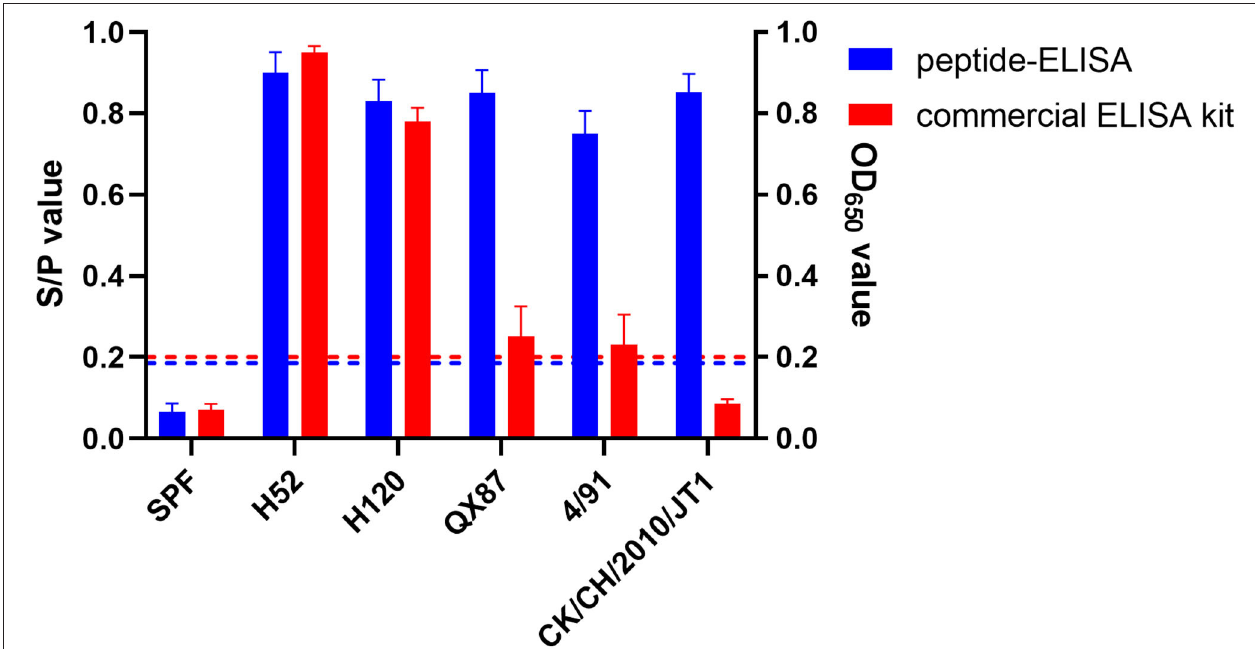
FIGURE 3 | Reactivity of pELISA and positive sera against different genotype IBVs. Two colors showed the results of pELISA and commercial ELISA kits. The blue horizontal dotted line indicates the cutoff of pELISA, and the red horizontal dotted line indicates the S/ P -value of the commercial ELISA kit. pELISA had very good reaction with sera to different genotype IBV strains, but the commercial ELISA kit gave a strong reaction with only mass-type positive sera. H52 and H120 vaccine strains belong to mass type; 4/91 vaccine strain belongs to 4/91 type; QX87 vaccine strain belongs to QX-type; CK/CH/2010/JT1 virulent strain belongs to new cluster